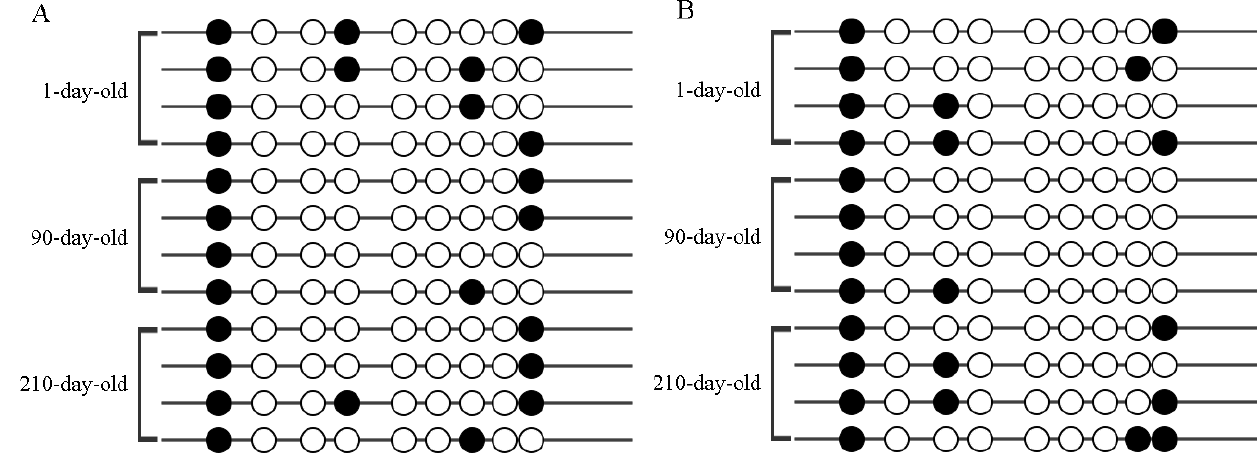
Figure 2. The methylation pattern of CpG island 2 of each Putian Black pig at different ages. (A) Adipose tissue, (B) skeletal muscle. Every circle represents a CG, black circles mean methylated CG, and white circles mean unmethylated CG. CpG and CG, cytosine-guanine dinucleotide.